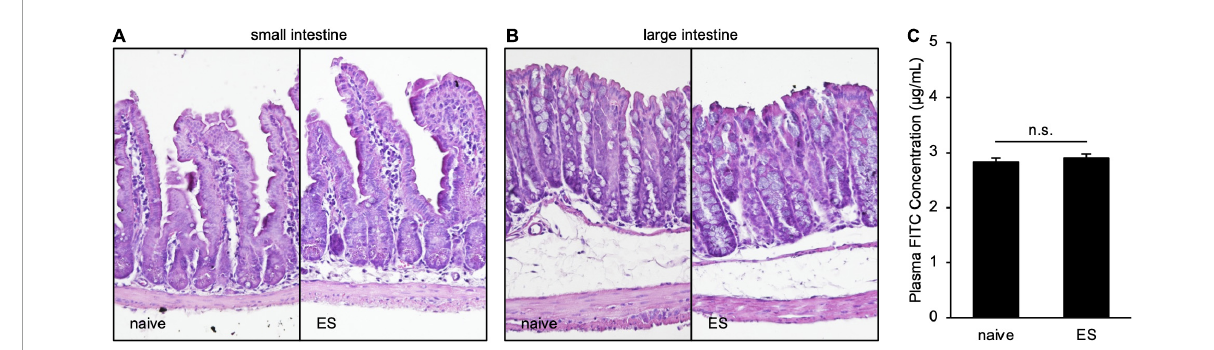
FIGURE4 Chronic vicarious social defeat stress does not affect pathological states. (A,B) Representative images of hematoxylin–eosin staining of small intestine (A) and large intestine (B) . Histological and inflammatory statuses are evaluated by epithelial surface damage, crypt damage, the number of inflammatory cells, and presence of ulceration. (C) Plasm FITC concentration 1 h after the administration of FITC-dextran (MW 4000) on Day 11. Data are presented as means ± s.e.m., and analyzed using Student’s t -test. n = 12 for each